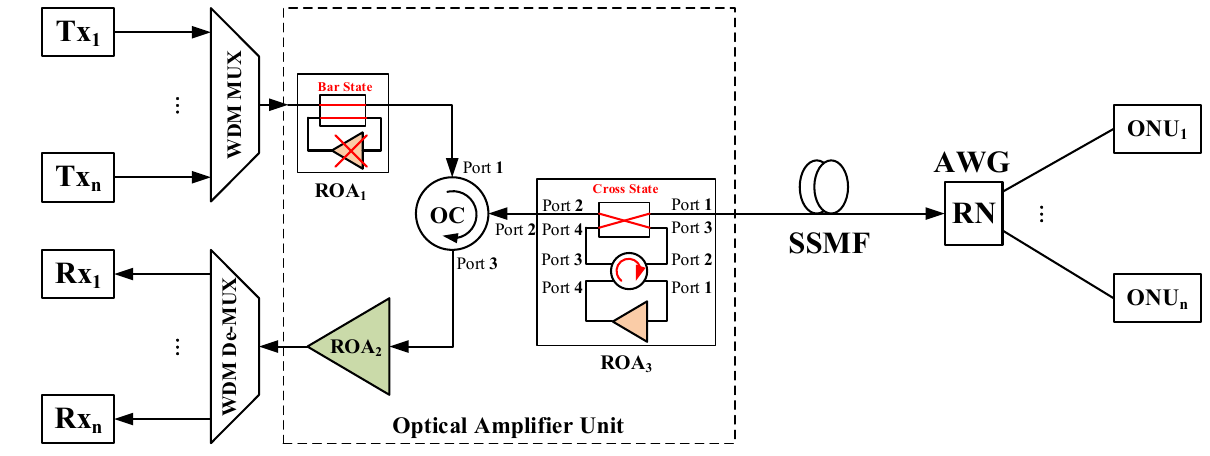
Figure 3. Protection state for ROA 1 .